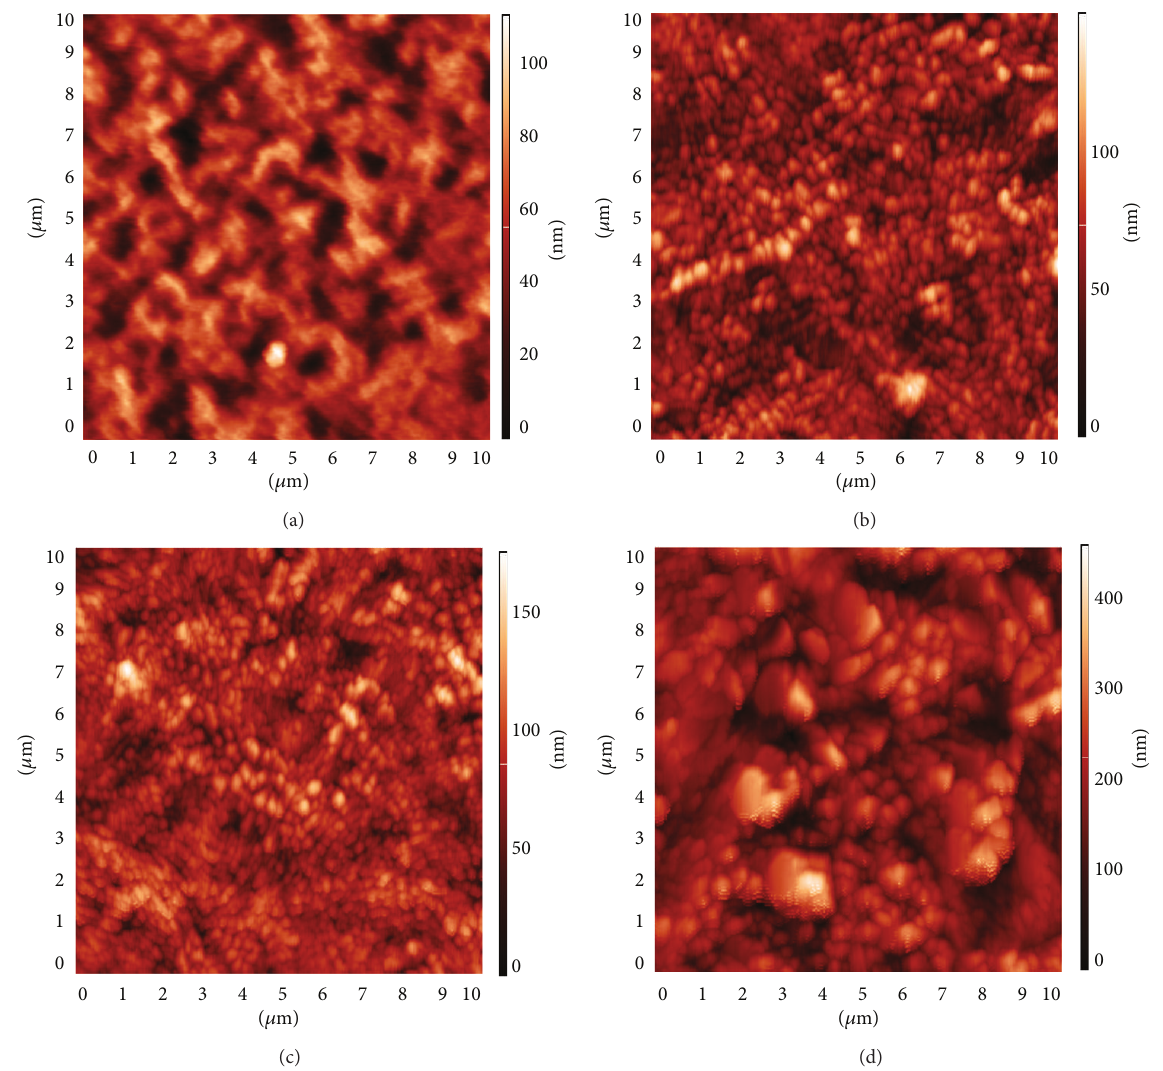
Figure 3: AFM images of P3HT:PCBM film doped with nanodiamond at concentrations of (a) 0, (b) 0.5, (c) 1.5, and (d) 3 wt%.